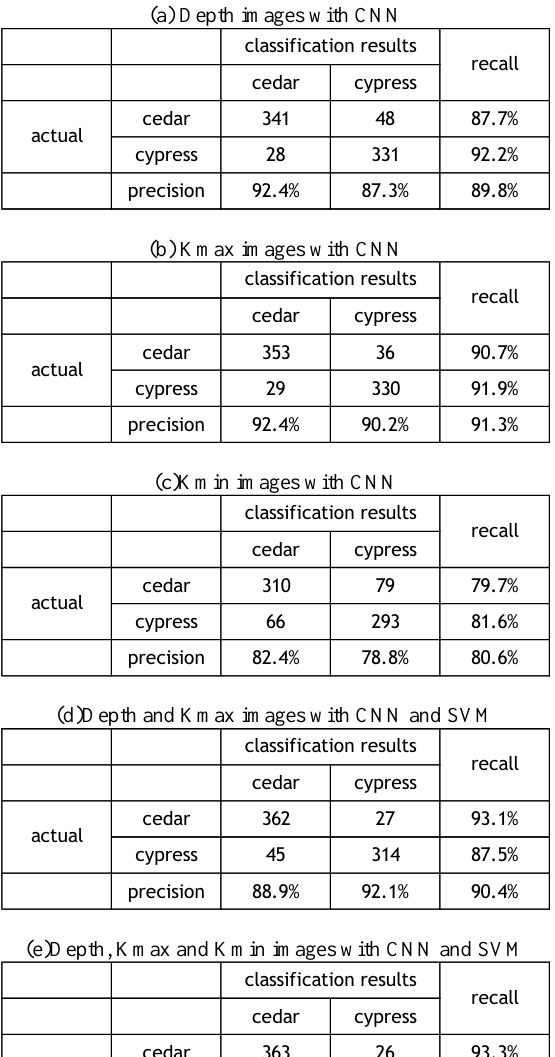
Table 1. Classification results of tree species (a) Depth images with CNN cedar cypress cedar cypress